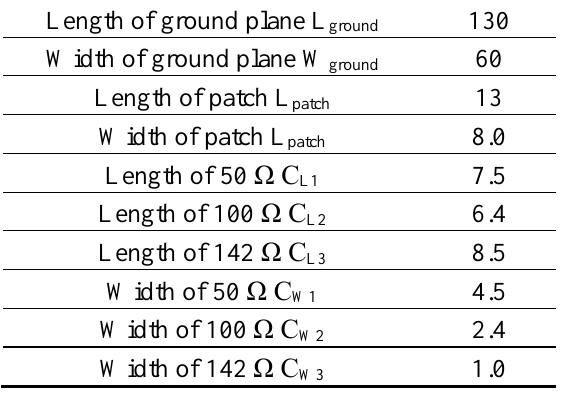
Figure 10. CAD model of the receiving patch antenna designed using commercial software [15]. Table 3. Dimensions (mm) of the geometrical parameters of the receiving